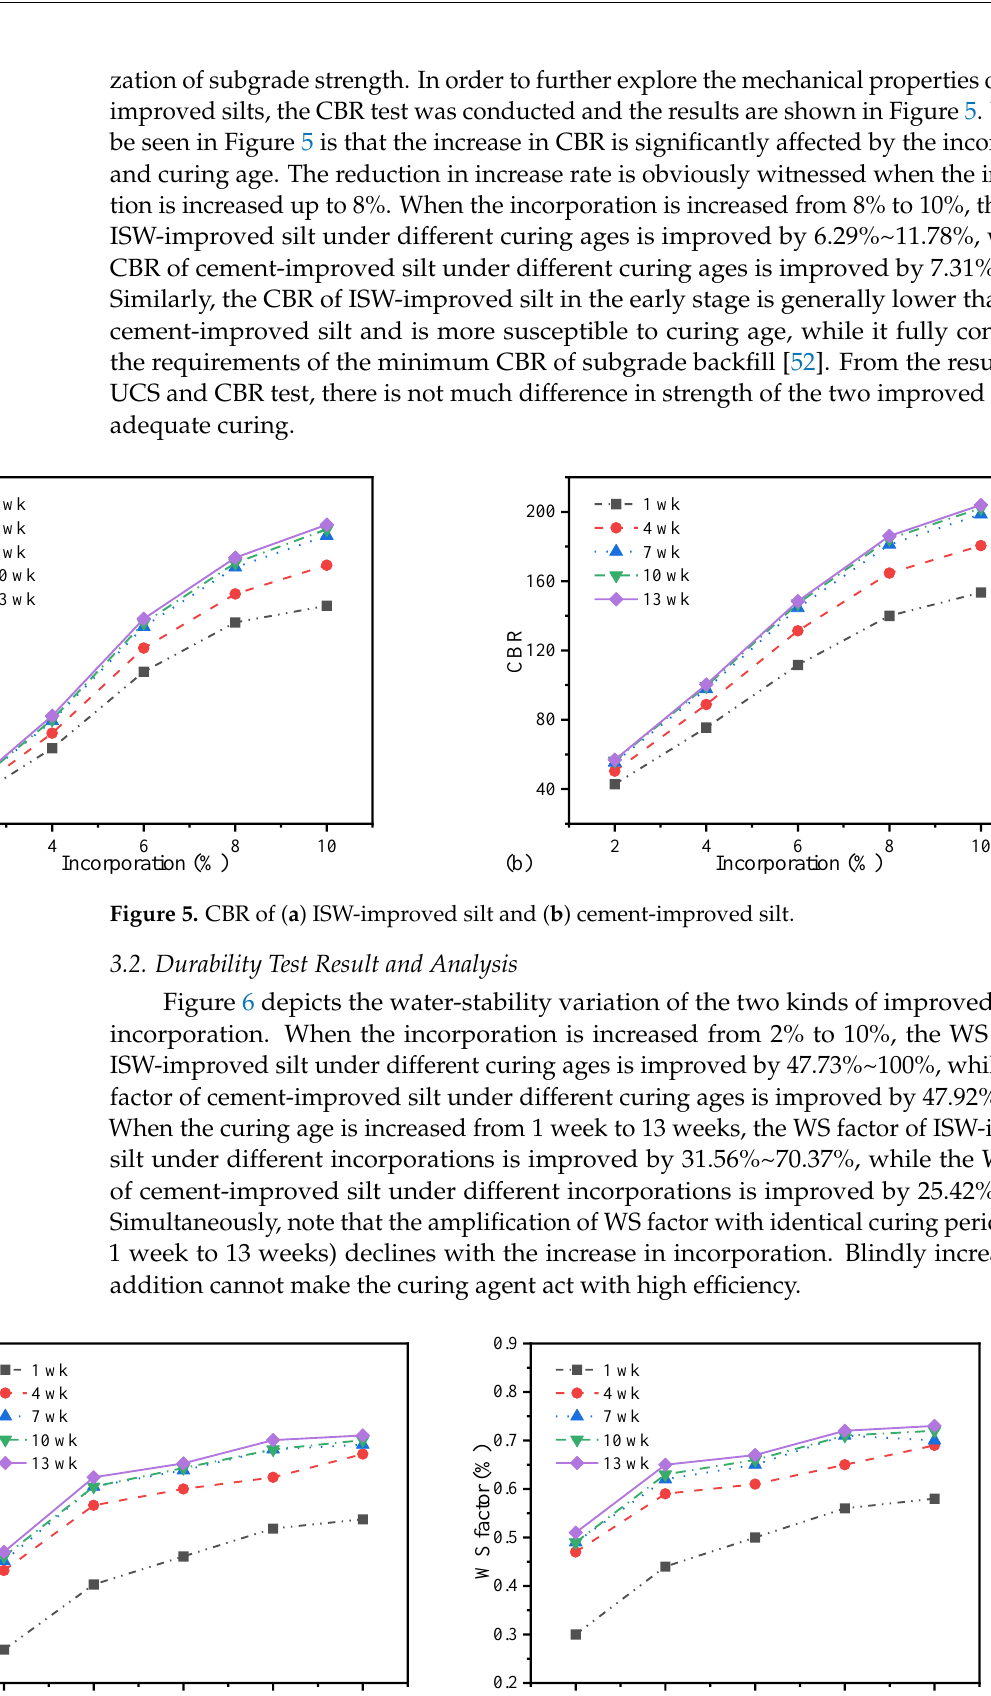
Figure 6. WS factor of ( a ) ISW-improved silt and ( b ) cement-improved silt. WD cycles could deteriorate soil microstructure and incur strength heterogeneity.